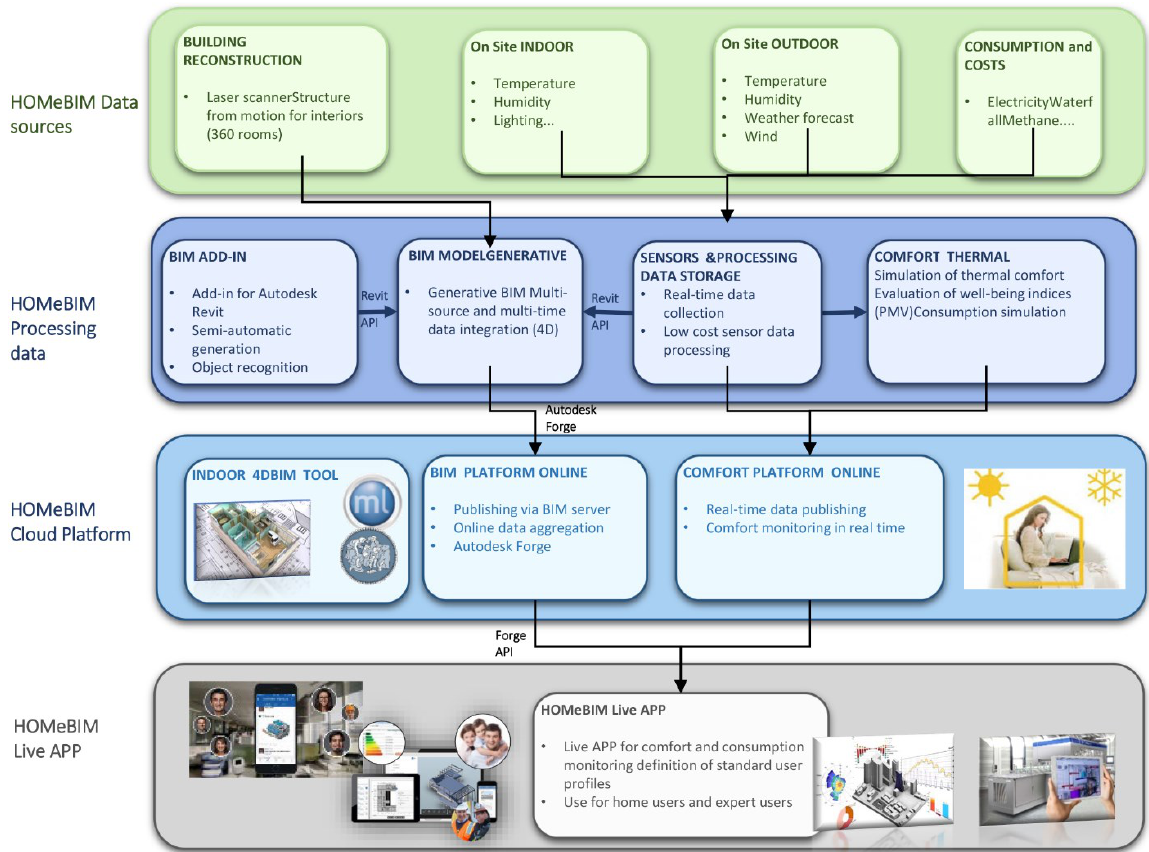
Figure 1. Digital workflow proposed and applied to the research case study.